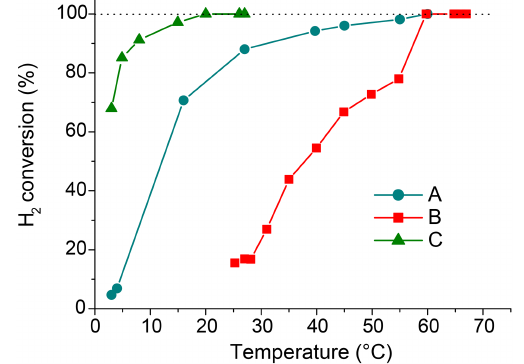
Figure 3. Modelling of the thermal